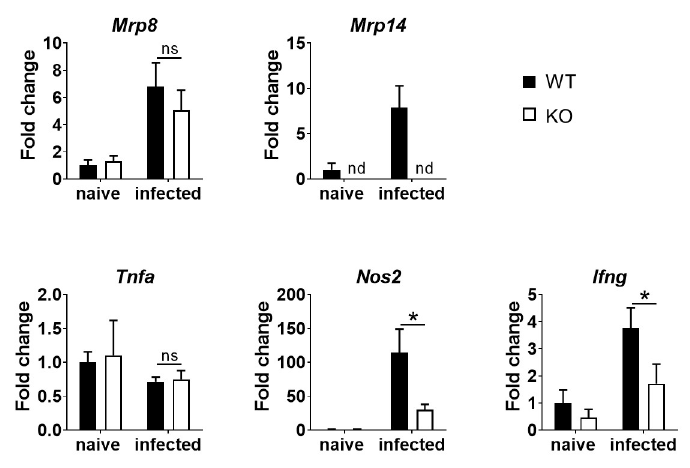
Fig 5. MRP14-dependent expressions of IFN- γ and NOS2 genes in the spleen of L . donovani -infected mice. The spleens were harvested from na ï ve or L . donovani -infected WT (n = 4 or 5) and MRP14KO mice (n = 4 or 5) and total RNA was purified from the tissues. Expression levels of MRP8, MRP14, TNF- α , NOS2 and IFN- γ mRNA in the organs were measured by quantitative PCR. Mean and SD of each group are shown. ns, not significant, � P < 0.05 by Mann- Whitney test. These are a representative of three independent experiments with similar